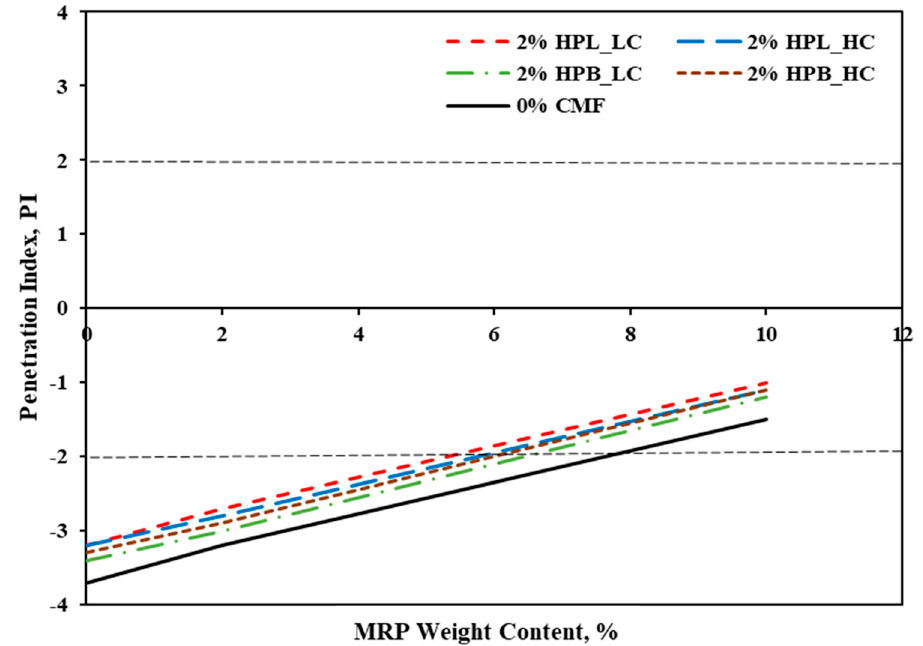
Figure 8. Effect of MRP content and CMF type on penetration index at 2% CMF content.